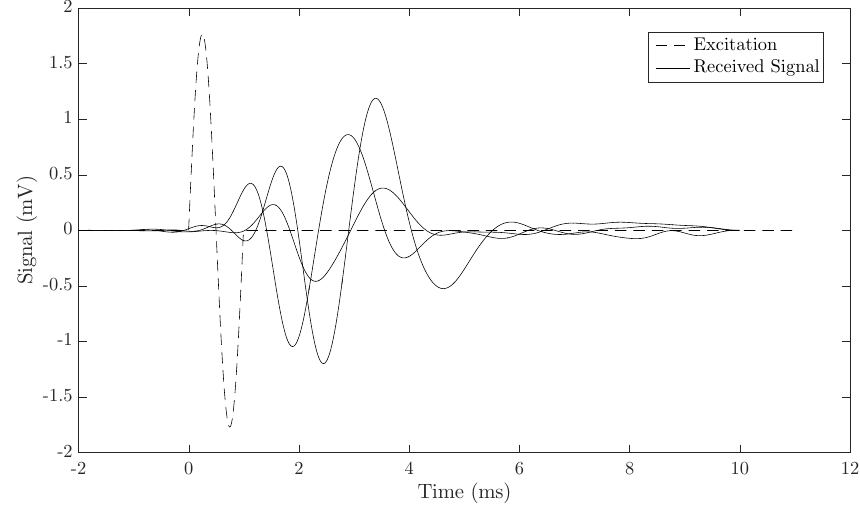
Figure 3. Example of three emitted and received 1 kHz